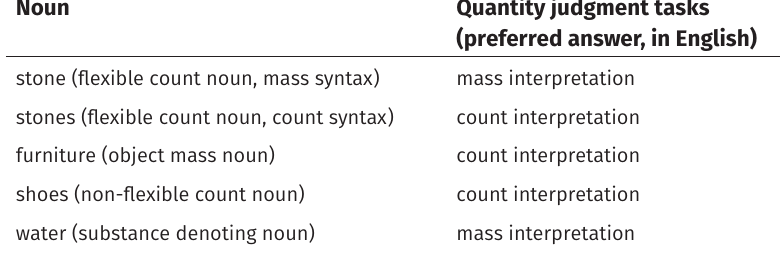
Table 1: Summary: results of quantity judgment tasks across different types of nouns in English (based on Barner & Snedeker